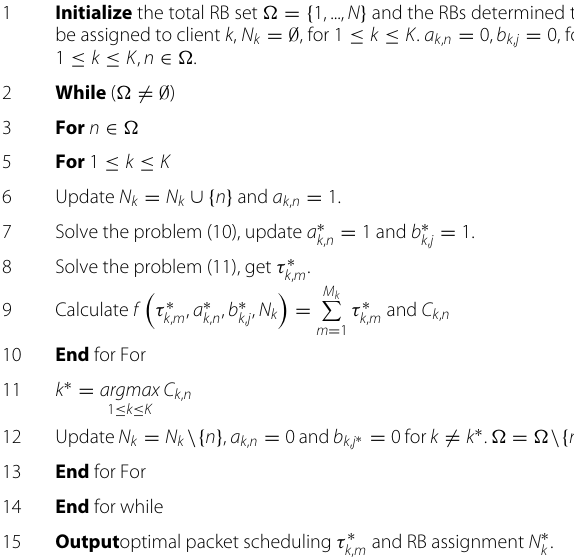
Table 3 Packet scheduling and resource management scheme Table 4 Procedure of estimation of T mac ( k